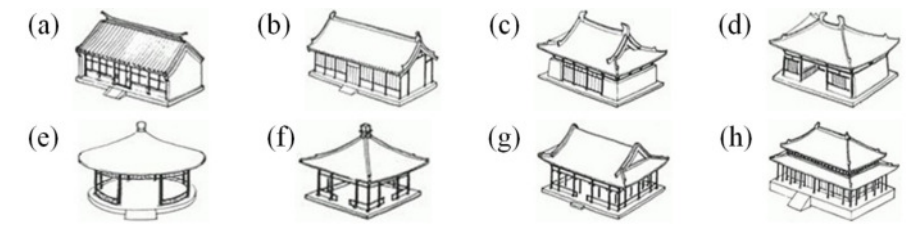
Figure 2. Examples of common ancient Chinese-style architecture that incorporated different roof styles. ( a ) Hip roof; ( b ) flush gable roof; ( c ) overhanging gable roof; ( d ) gable-hip roof; ( e ) pyramidal pavilion roof; ( f ) round pavilion roof; ( g ) round gable-hip roof; ( h ) double-eave hip roof.